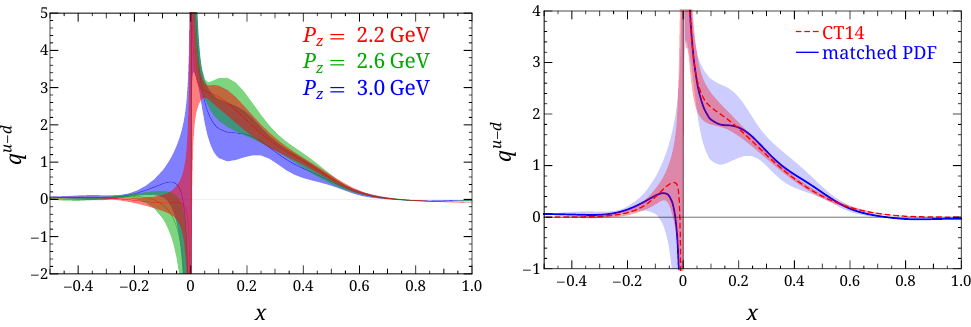
Figure 1. (Left) Nucleon boost-momentum dependence of the matched unpolarized isovector PDFs. For the quark asymmetry, the shape is consistent throughout most x regions. However, in the antiquark region, there is a significant change in distribution as momentum increases. (Right) Our final PDF renormalized at 3 GeV and compared with CT14 [48], which is consistent with NNPDF3.1 [49] and CJ15 [50]. Our results agree nicely with the global-analysis PDF. More details about these figures can be found in Ref.